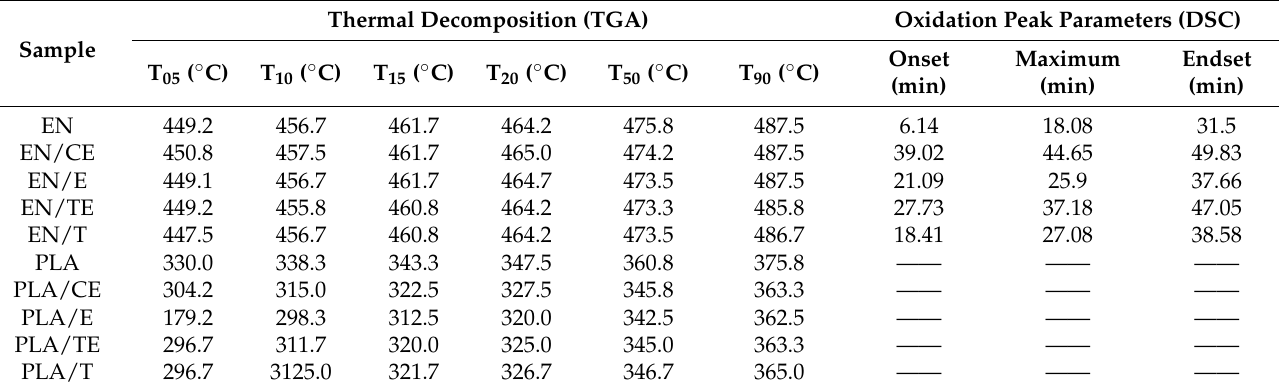
Table 2. Parameters assigned to the thermal decomposition and the oxidation process of analyzed samples; T x —temperature at which the mass loss of x% is